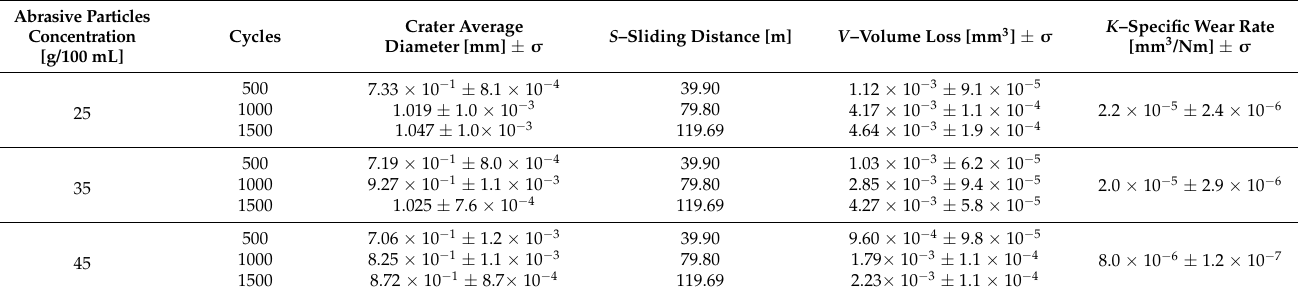
Table 5. Specific wear rate obtained for the TiN films as a function of the abrasive slurry concentration and sliding distance under a normal load of 2